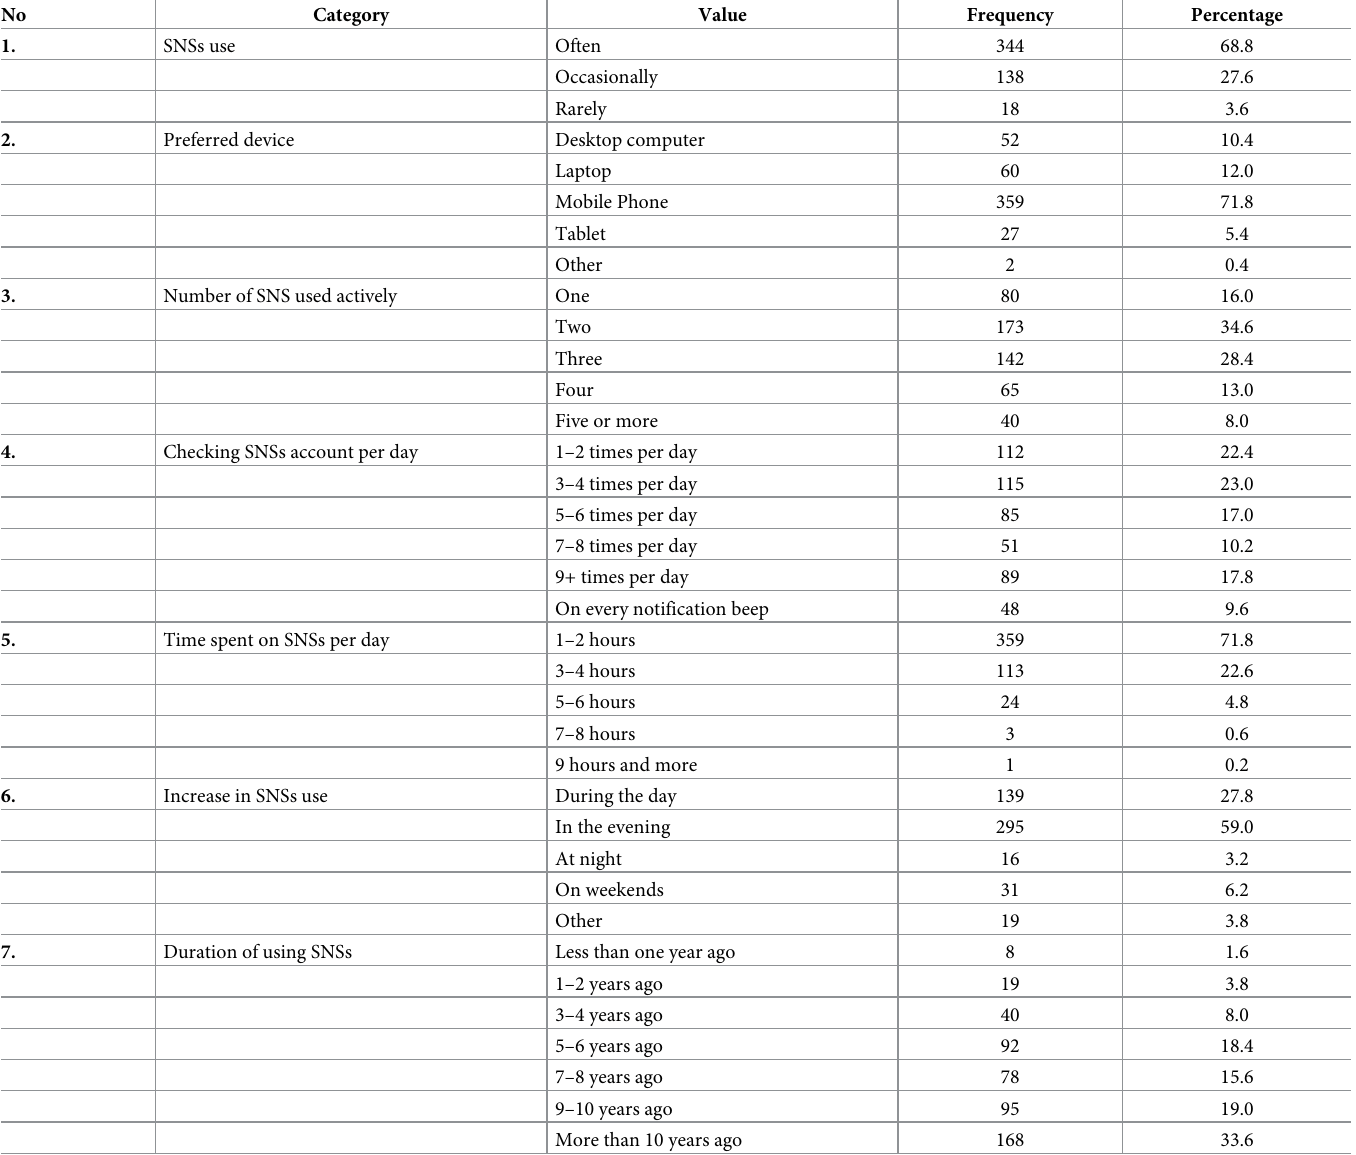
Table 4. SNSs usage pattern reported using the SNSUN scale in Study